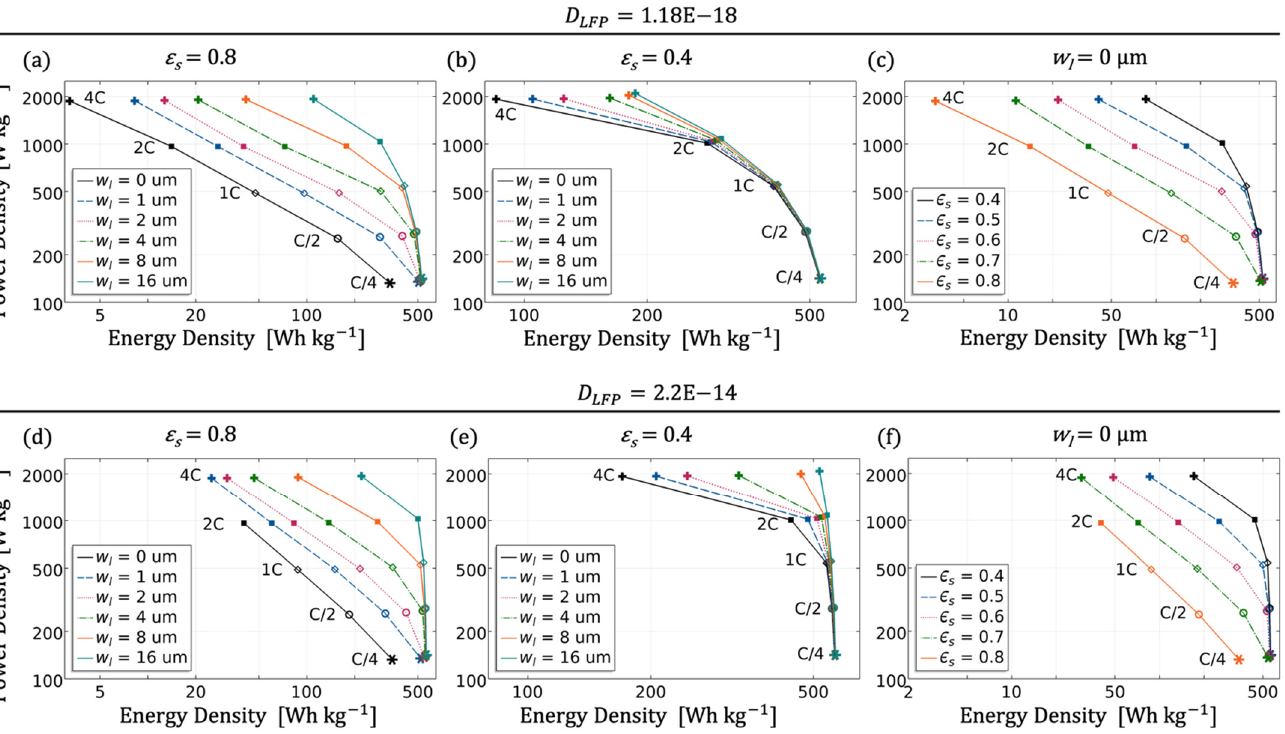
Figure 17. Ragone plot comparing the gravimetric energy vs. power density for different macro- and microstructure combinations. The energy density is obtained by multiplying the specific capacity with the average discharge voltage, and the power density is calculated by dividing the energy density by the discharge time. The variation of the electrolyte channel width is shown with a dense ( a ) and with a porous ( b ) lamella at D LFP = 1.18 × 10 − 18 and with D LFP = 2.2 × 10 − 14 ( d , e ) as long with the variation of the solid content in a single structure porous electrode ( c , f ).